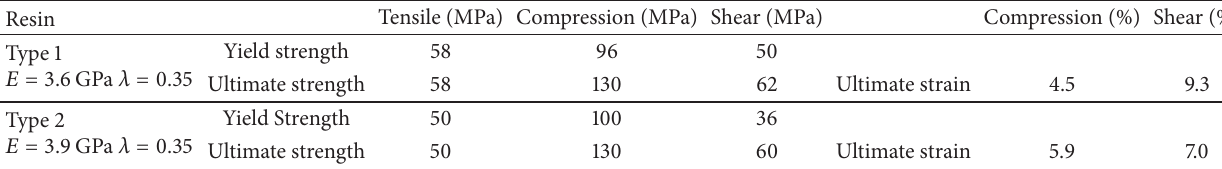
Table 1: Typical resin material strength data [7].